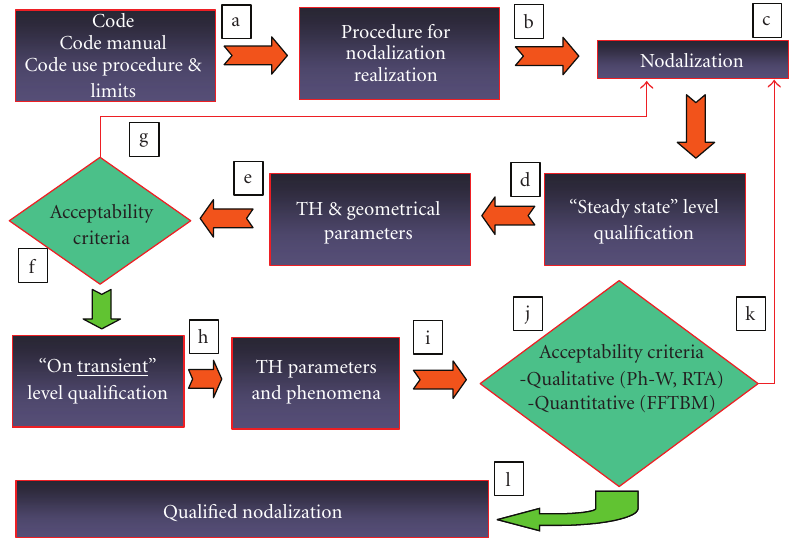
Figure 8: Flow sheet of nodalization qualification